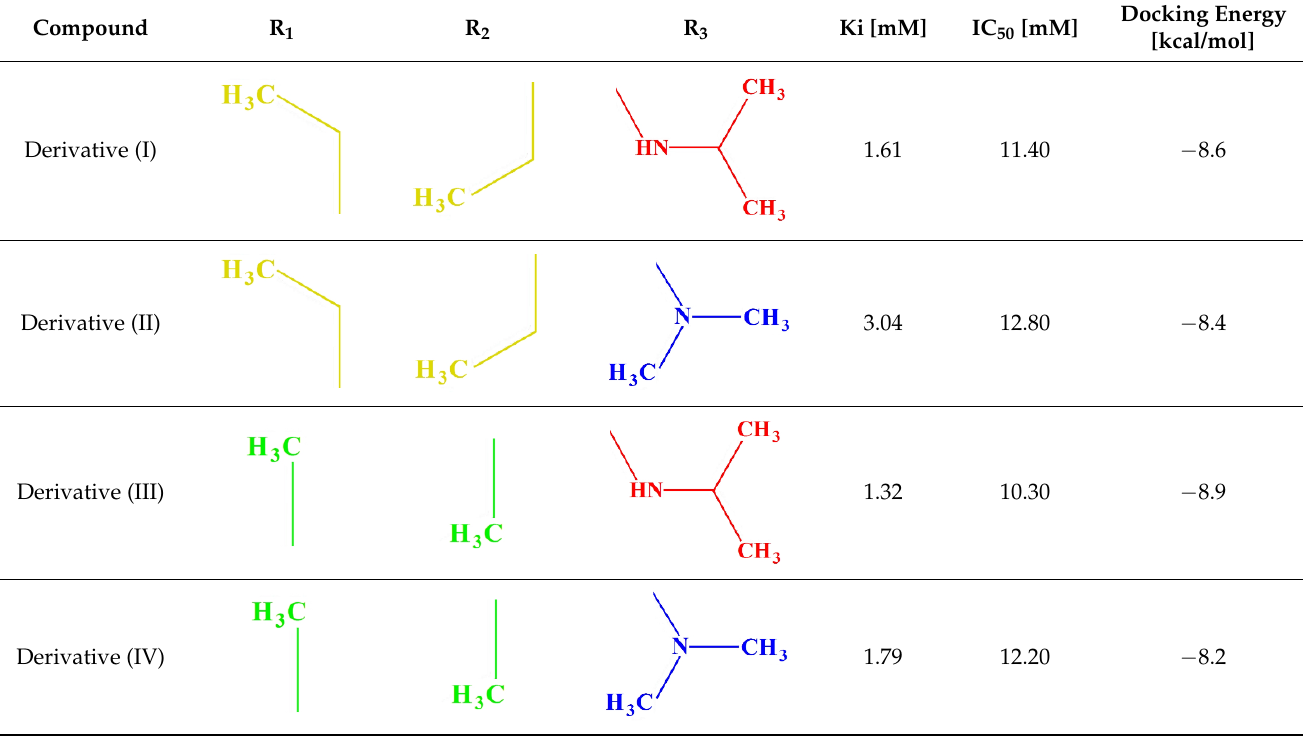
Table 5. The higher scoring function ( −8 .9 kcal/mol) was obtained for compound III and a slightly lower value was predicted for compound I ( −8 .6 kcal/mol); both (III and I) con- tained the isopropyl substituent. The prediction values obtained for the compounds containing the dimethyl amino substituent were slightly lower and amounted to −8 .4 kcal/mol for compound II and −8 .2 kcal/mol for compound IV, respectively. The obtained values were in good agreement with the experimental data.